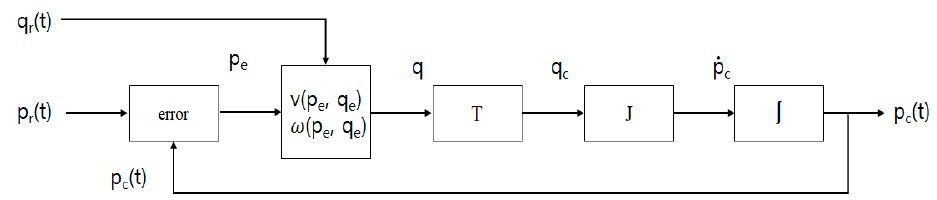
Figure 10. The architecture of the tracking controller.